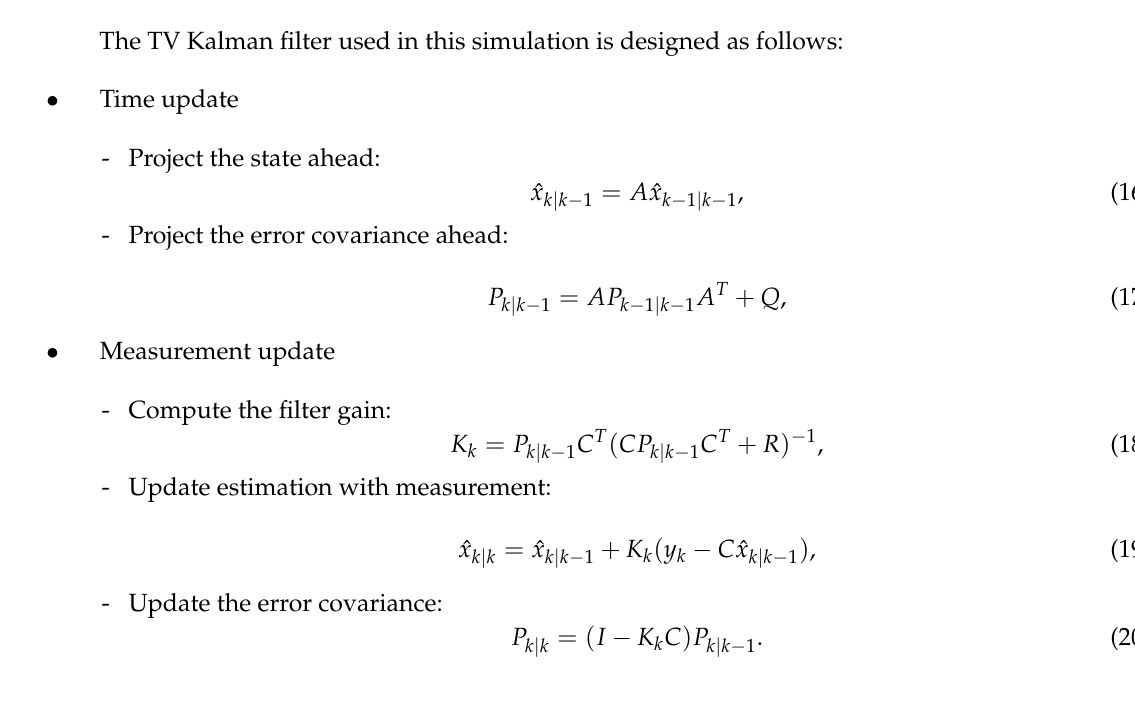
Figure 1. Waveform of test signal (Case